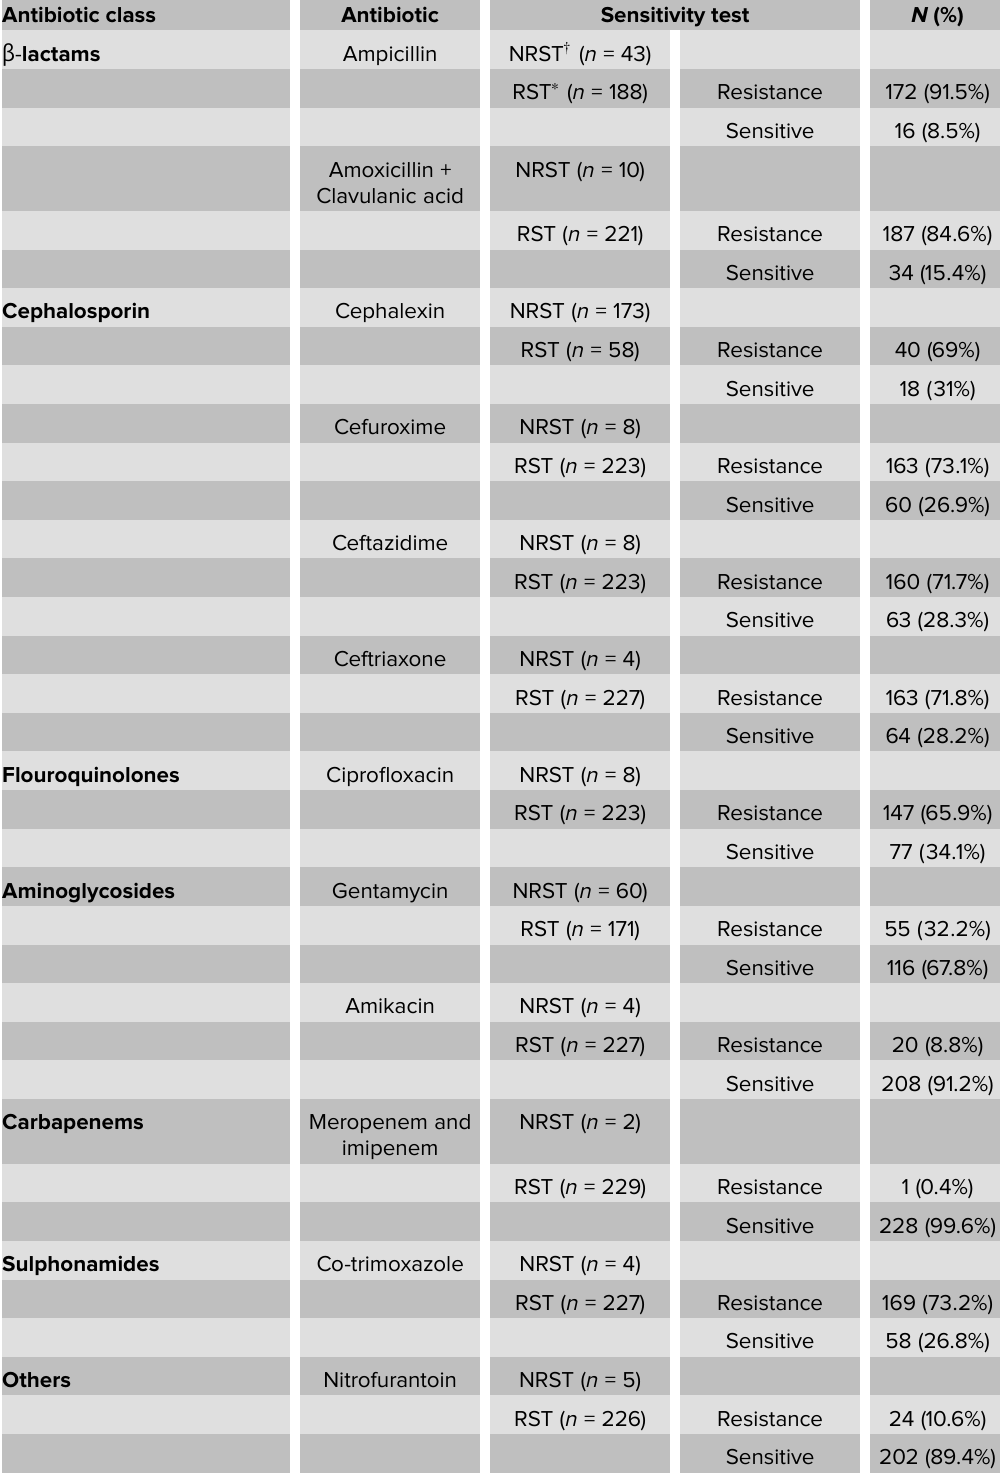
Table 2: Distribution of study sample according to sensitivity pattern ( n =